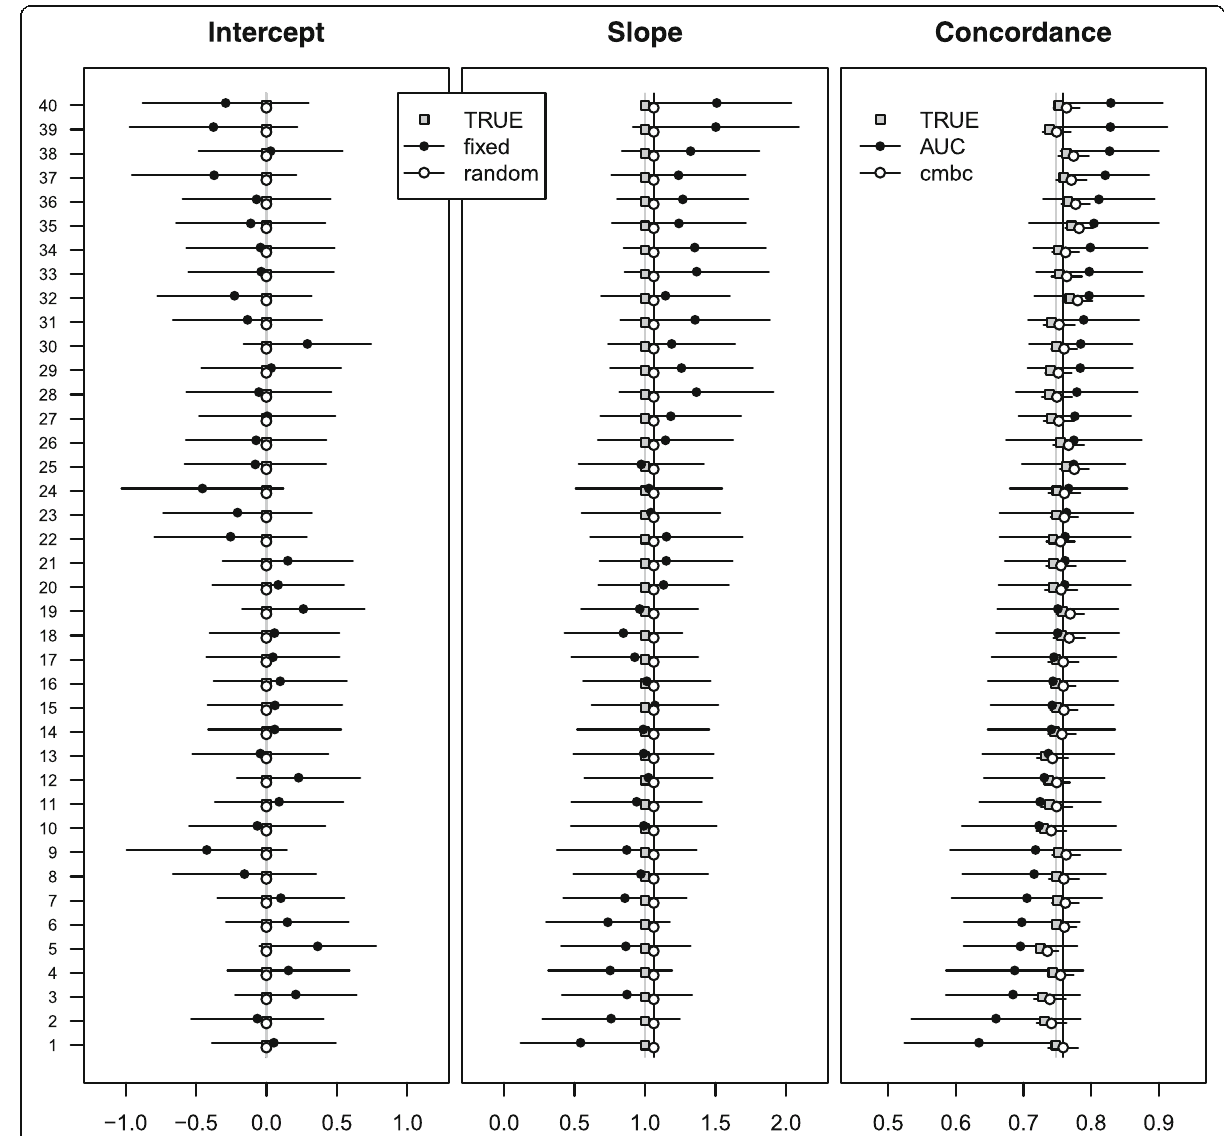
Fig. 4 Performance measures across 40 centers of simulated 200 patients without between center heterogeneity in intercept and slope. Gray squares represent true values of intercept, slope, and concordance probability. Closed dots represent fixed effect intercept estimates; fixed effect slope estimates; and c-indexes in the first, second, and third panel, respectively. Open dots represent random effects intercept estimates; random effects slope estimates; and calibrated model-based concordance estimates in the first, second, and third panel, respectively. Gray vertical lines represent effect estimates of intercept and slope in the original regression model, together with the expected pooled concordance. Black vertical lines represent fixed effect estimates of intercept and slope in a multilevel regression model, together with the expected pooled